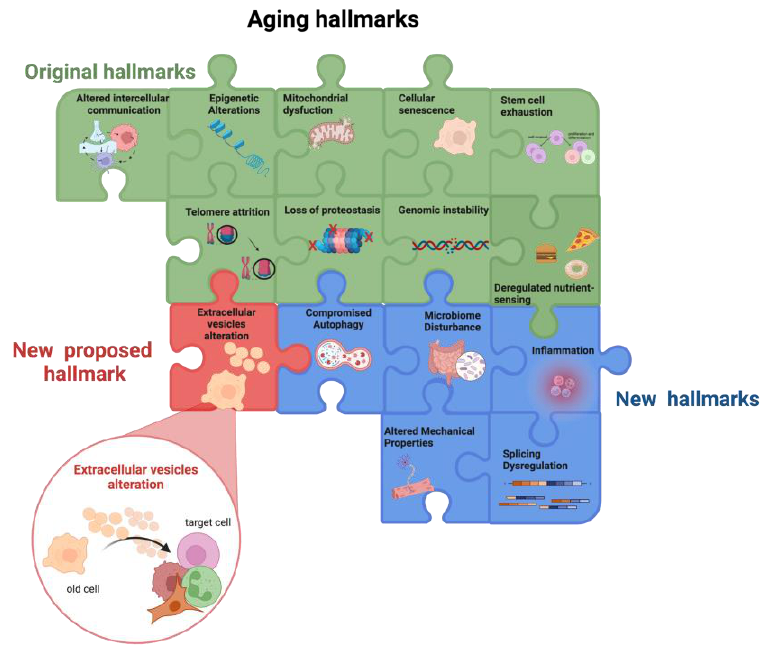
Figure 1. Aging hallmarks. The colored puzzle pieces represent the different hallmarks of aging: in green the original hallmarks and in blue the new hallmarks defined at the Copenhagen Meeting on Aging 2022. In this review, we propose “ the alteration in extracellular vesicles ” as an additional new hallmark of aging (in red). Other potential new hallmarks emerging from future studies will lead to puzzle completion. Created by BioRender.com (accessed on 18 January 2023).